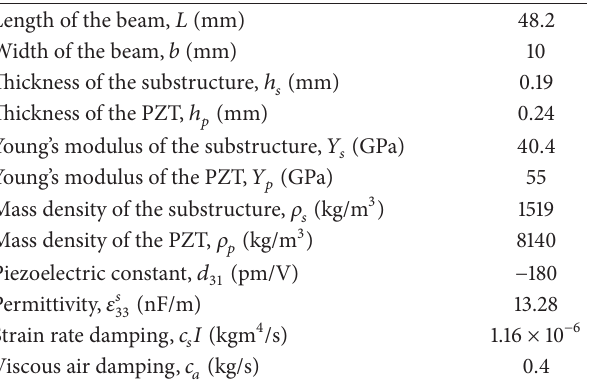
Table 1: Parameters of the bimorph beams.